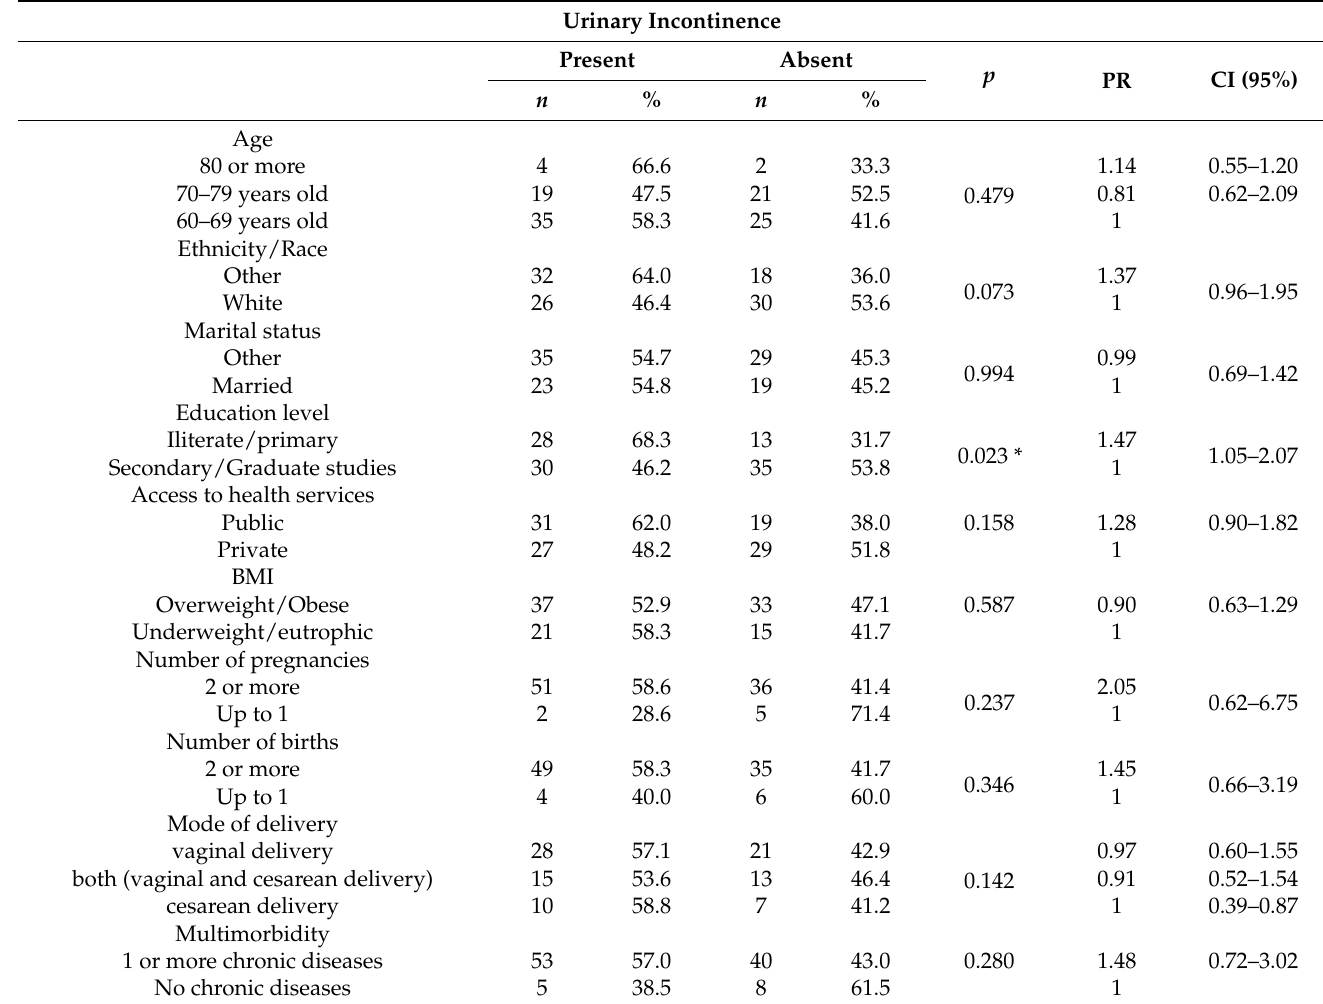
Table 2. Bivariate analysis between socioeconomic characteristics, clinical records, and urinary incontinence in older women who practice physical exercise. Natal, Brazil